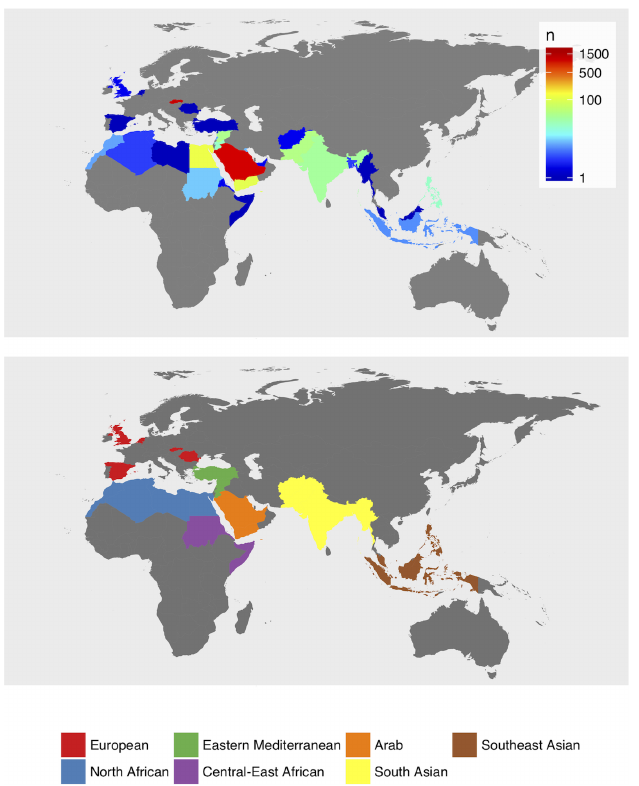
Fig 1. Ethnicities and sample numbers for all study participants (upper panel); geographic stratification for subsequent statistical analysis (lower panel).